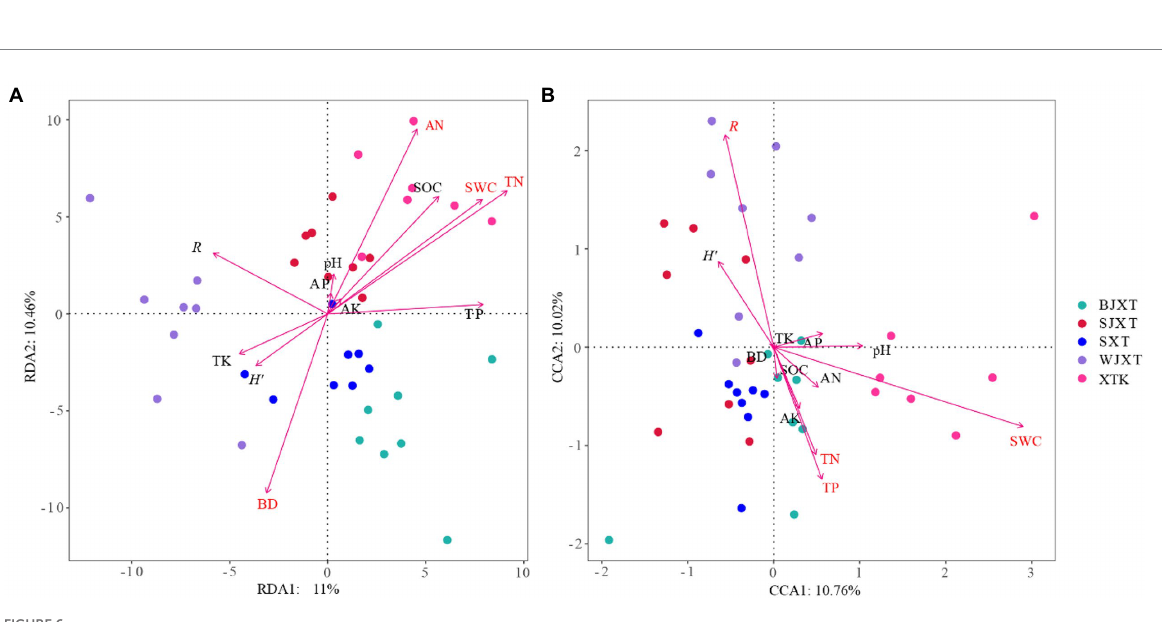
FIGURE 6 The redundancy analysis (RDA) of the bacterial (A) and fungal (B) communities with soil and plant properties in five karst tiankengs. Mark the significant factors in red